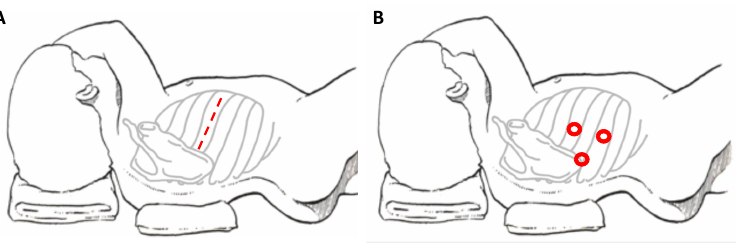
Figure 1. Patient’s position and site of incision in thoracotomy ( A ) and thoracoscopy ( B ), respectively.